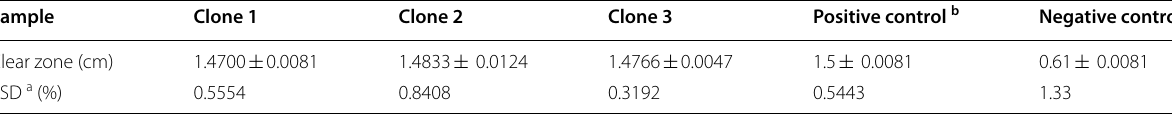
Table 4 The results of radial caseinolytic assay for SAK activity